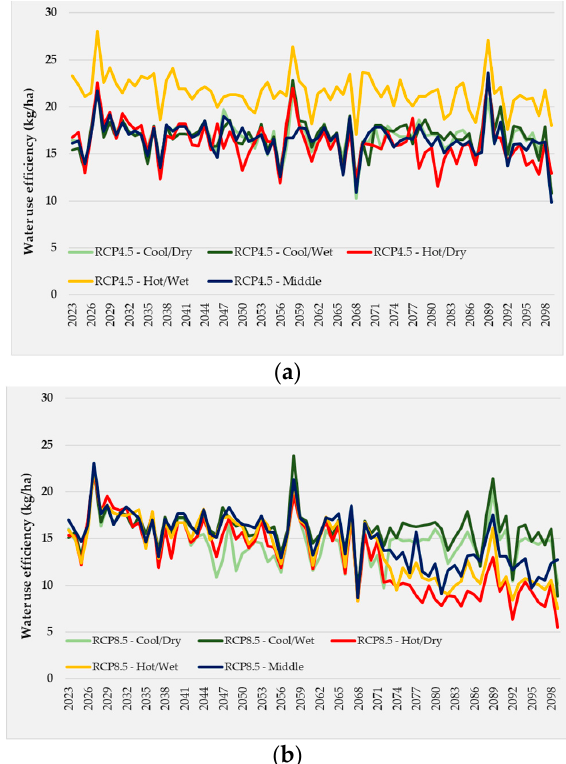
Figure 8 . Annual changes in water use efficiency for RCP 4.5 ( a ) and RCP 8.5 ( b ) . Figure 8. Annual changes in water use efficiency for RCP 4.5 ( a ) and RCP 8.5 ( b ).